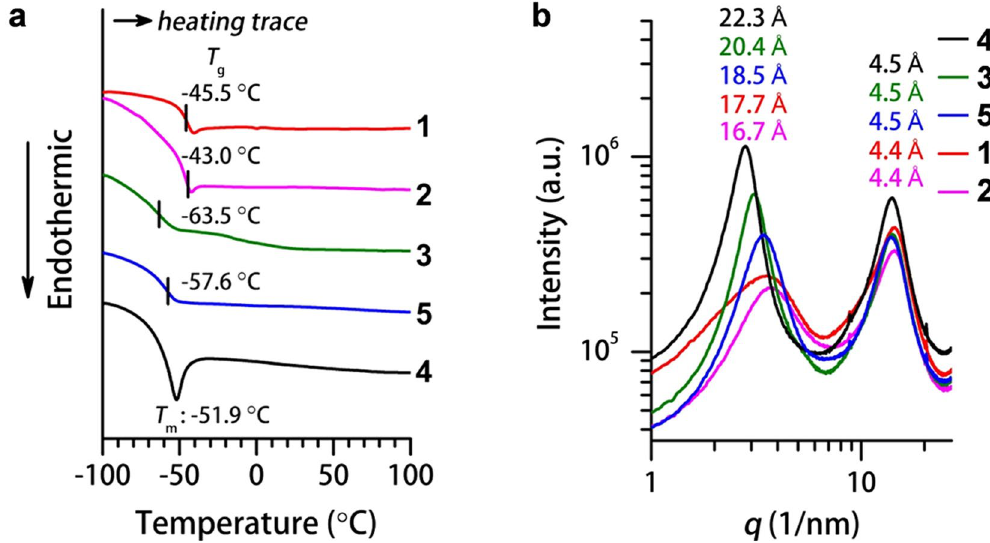
Figure 2. Phase properties and structural analysis of 1 – 5 . ( a ) Differential scanning calorimetry thermograms of 1 (red), 2 (pink), 3 (green), 4 (black) and 5 (blue) in the second heating trace at a scan rate of 10 °C min − 1 showing the glass -to- isotropic transition ( T g ) for 1 , 2 , 3 and 5 , and melting point ( T m ) for 4 . ( b ) Small and wide- angle X-ray scattering profiles of 1 (red), 2 (pink), 3 (green), 4 (black) and 5 (blue) at 25 °C.